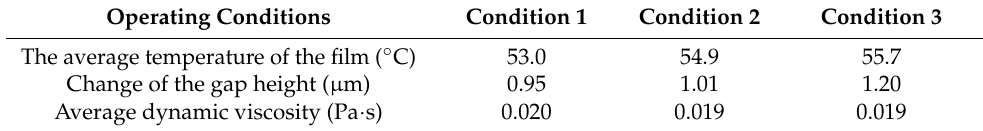
Table 2. Thermal analysis results.